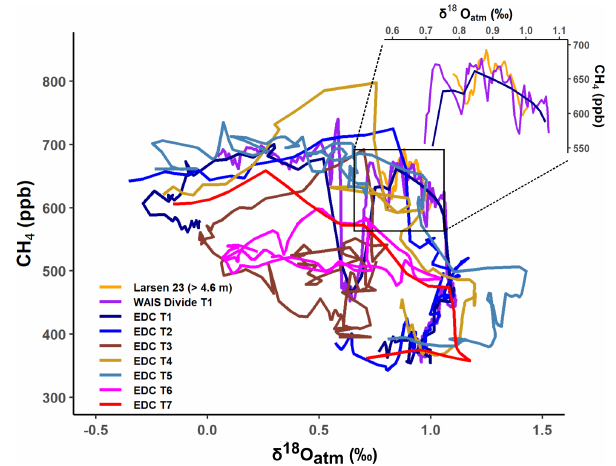
Figure 6. Comparison of the δ 18 O atm –CH 4 relationship in Larsen ice core no. 23 with existing records over glacial terminations. δ 18 O atm and CH 4 data of the WAIS Divide are from Severing- haus (2015) and Rhodes et al. (2017), respectively. δ 18 O atm of EDC is from Landais et al. (2013) and Extier et al. (2018a). The CH 4 record of EDC is from Bazin et al. (2013d). The area within the black box is magnified to compare the Larsen no. 23 record with those from the WAIS Divide T1 and EDC T1.